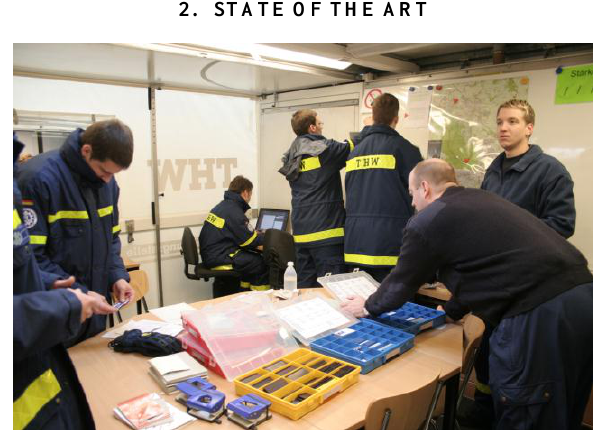
Fig. 1: THW rescue workers using conventional management